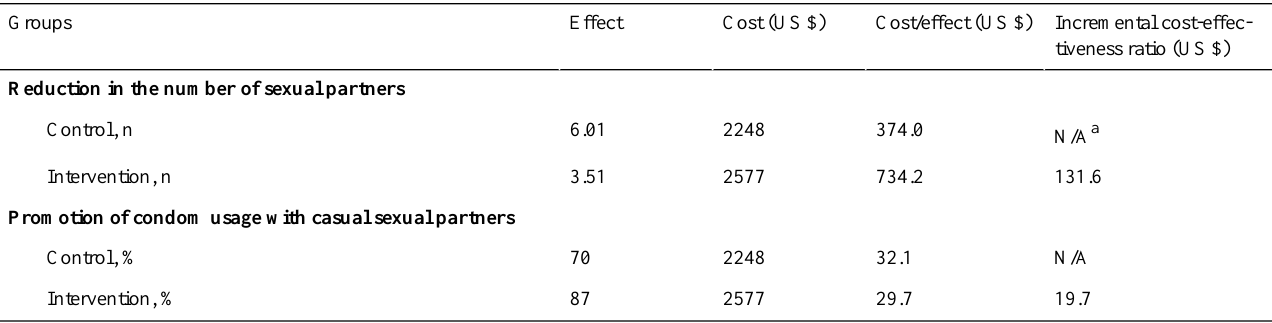
Table 3. Cost-effectiveness analysis of an eHealth intervention based on an HIV risk prediction model for men who have sex with men in China.